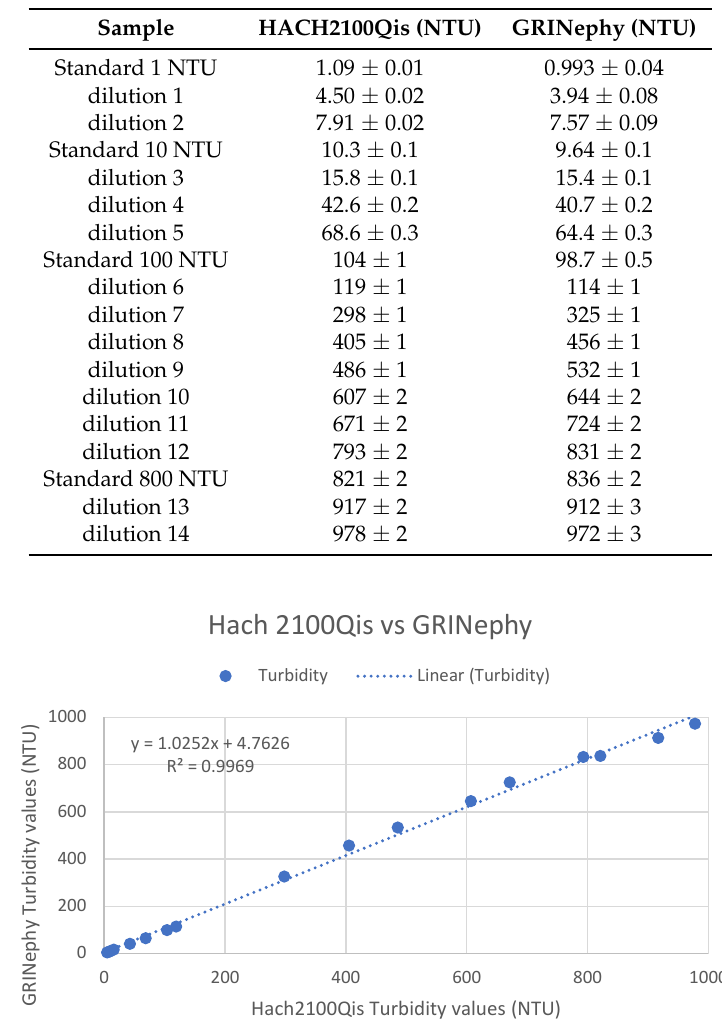
Table 2. Mean turbidity and standard deviation of measured standard StablCal R (cid:13) solutions and dilutions with the commercial Hach2100Qis nephelometer and our GRINephy.